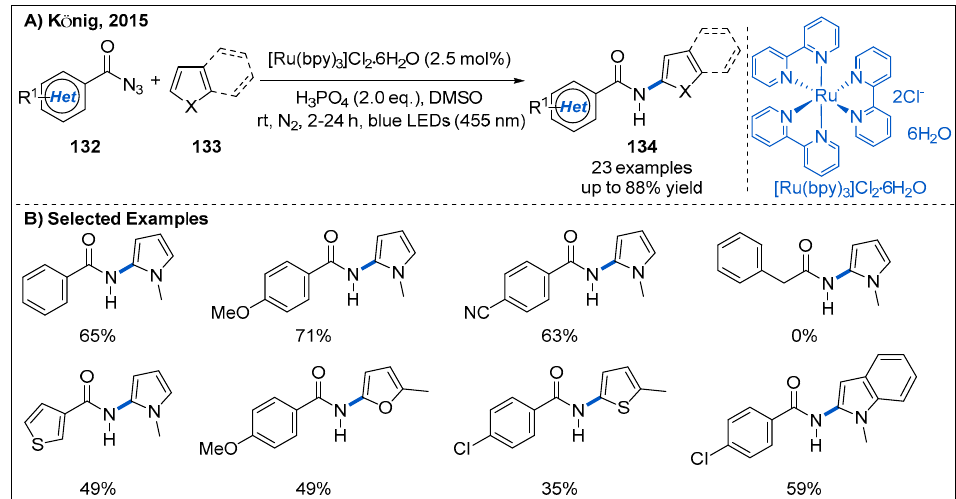
Figure 39. Visible-light-driven photoredox-catalyzed C-H amidation of heteroarenes with benzoyl azides.